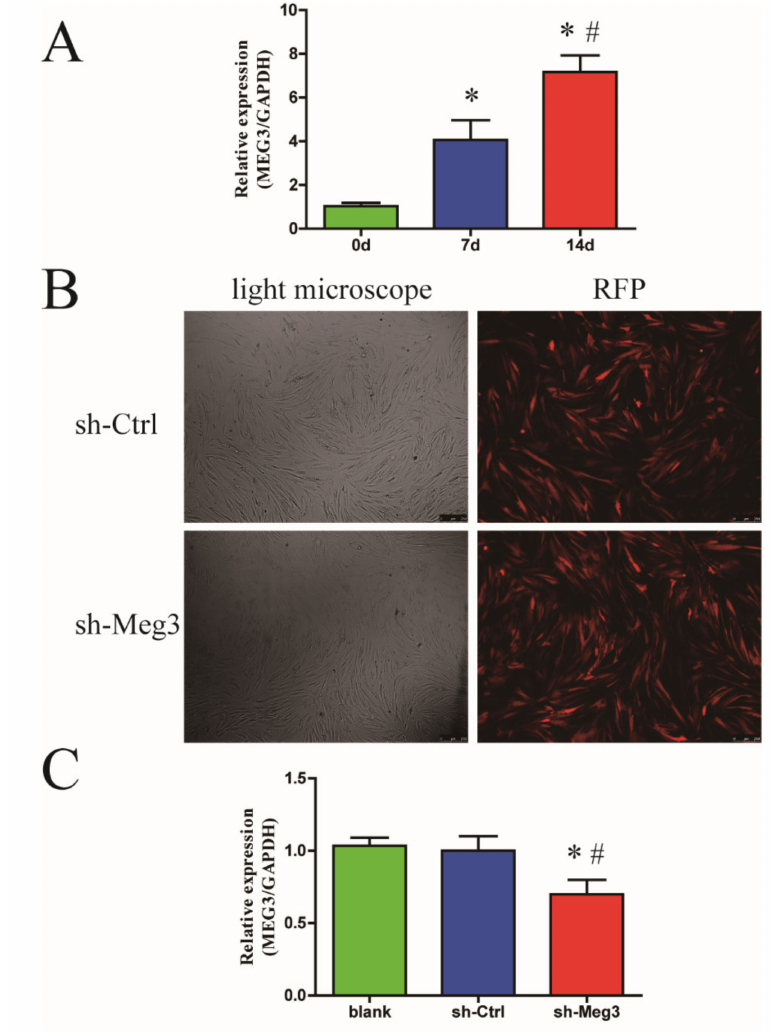
Figure 1. Expression of MEG3 during BMSCs osteogenic differentiation and MEG3 knockdown BMSCs. ( A ) Bar graphs show the expression levels of MEG3 in BMSCs at days 0, 7 and 14 of osteogenic differentiation. ( B ) BMSCs after lentiviral transfection were observed under an optical microscope and a fluorescence microscope. ( C ) The expression of MEG3 was determined by qPCR in lentivirus blank group, sh-Ctrl group and sh-Meg3 group ( n = 3/group). * p < 0.05 versus the blank group. # p < 0.05 versus sh-Ctrl